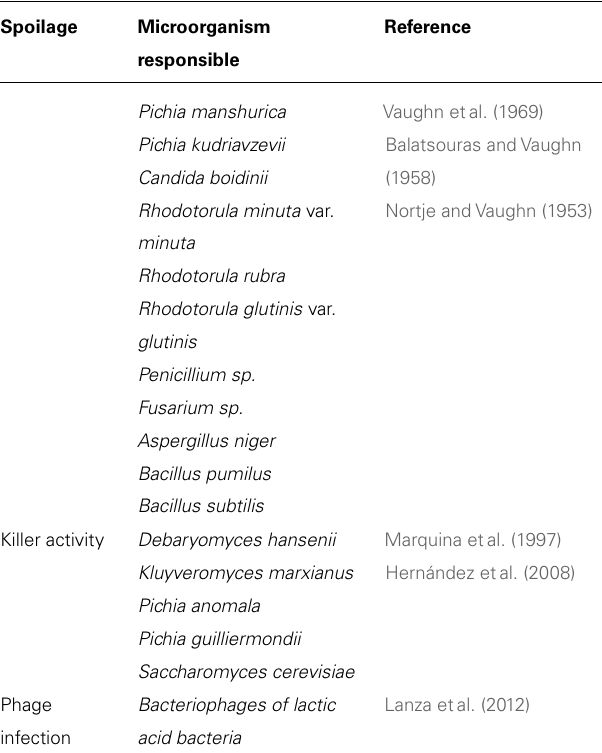
Table 1 |The main microbial alterations during table-olive processing. Red, defects that are detectable by sensory